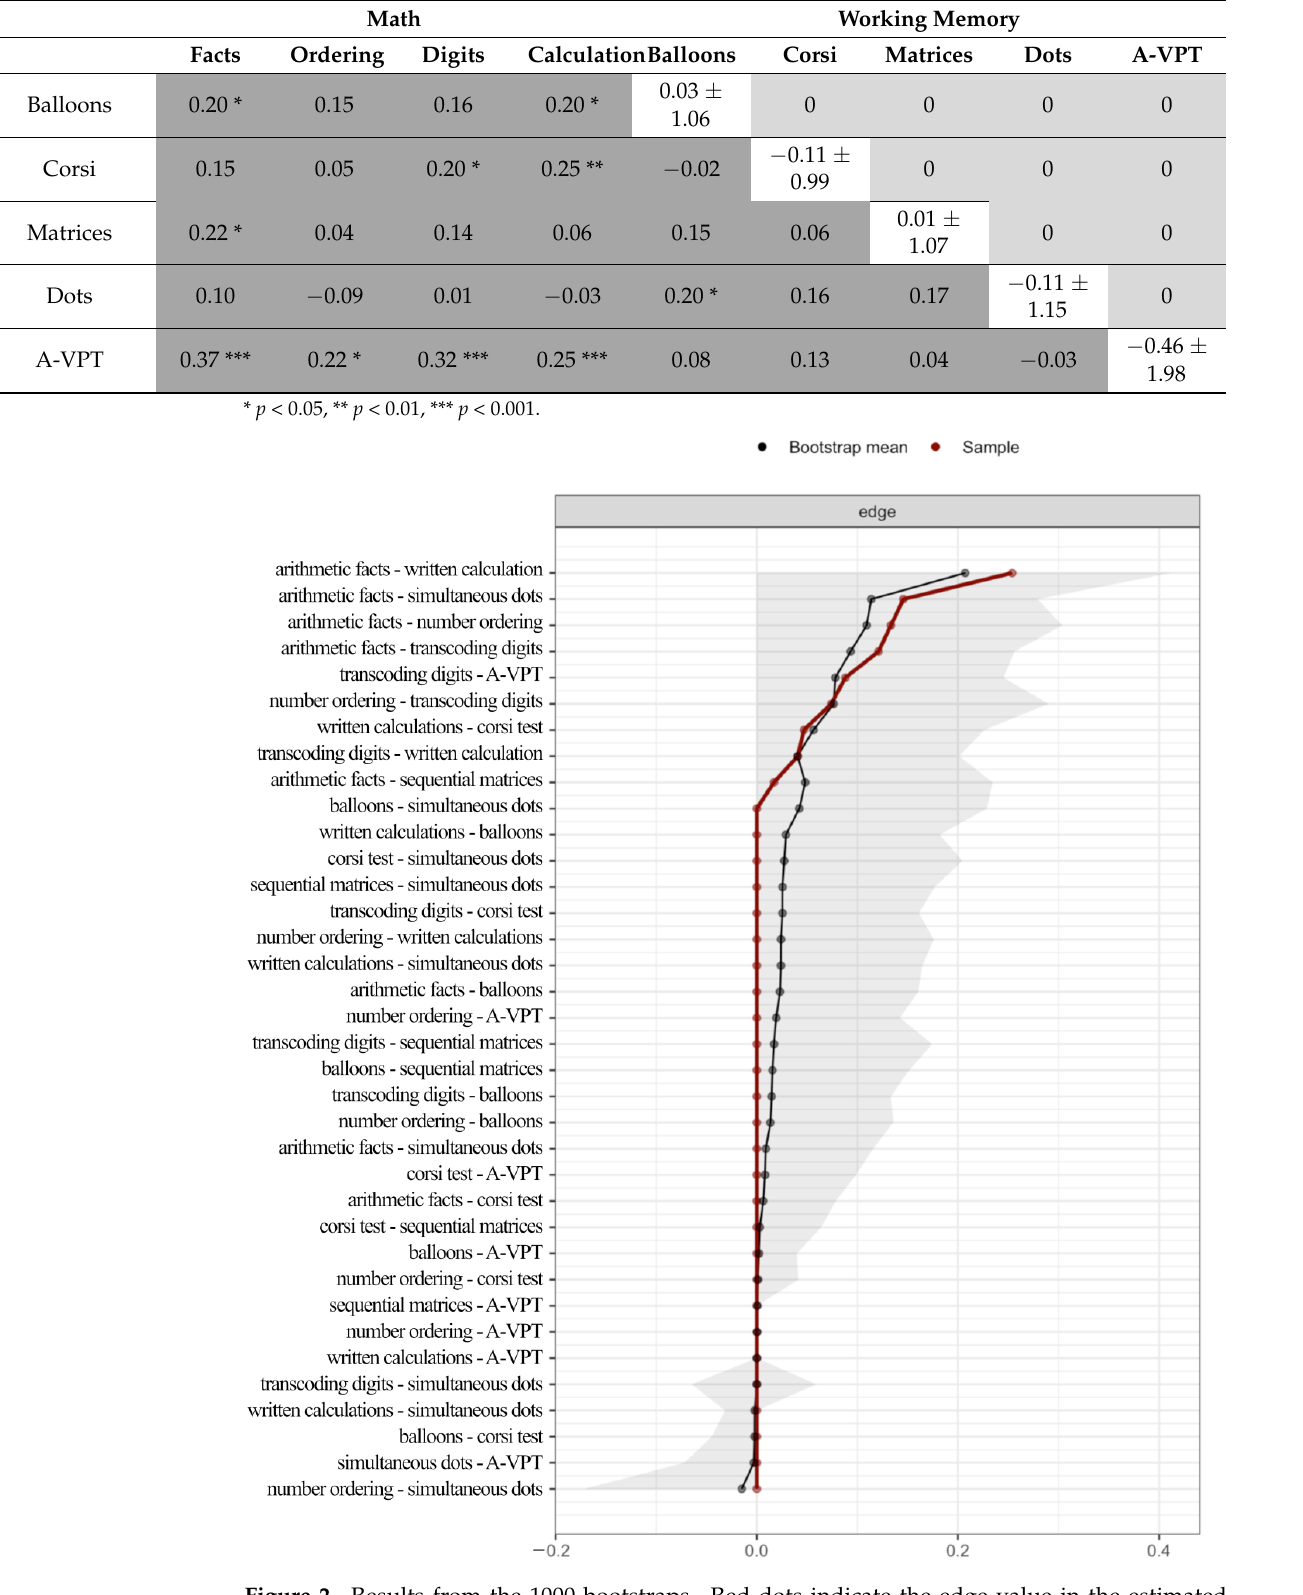
Figure 2. Results from the 1000 bootstraps. Red dots indicate the edge value in the estimated network. Black dots indicate the average edge value over 1000 bootstrap resampling. The grey shadow represents the 95% confidence interval estimated with the bootstrap resampling. Table 1. The lower part (highlighted in dark grey) reports the simple correlations, measured with Pearson’s r. The upper part (highlighted in light grey) reports the network weights, which corre- spond to regularized partial correlations. The diagonal reports the mean z scores ± the standard deviations. Math